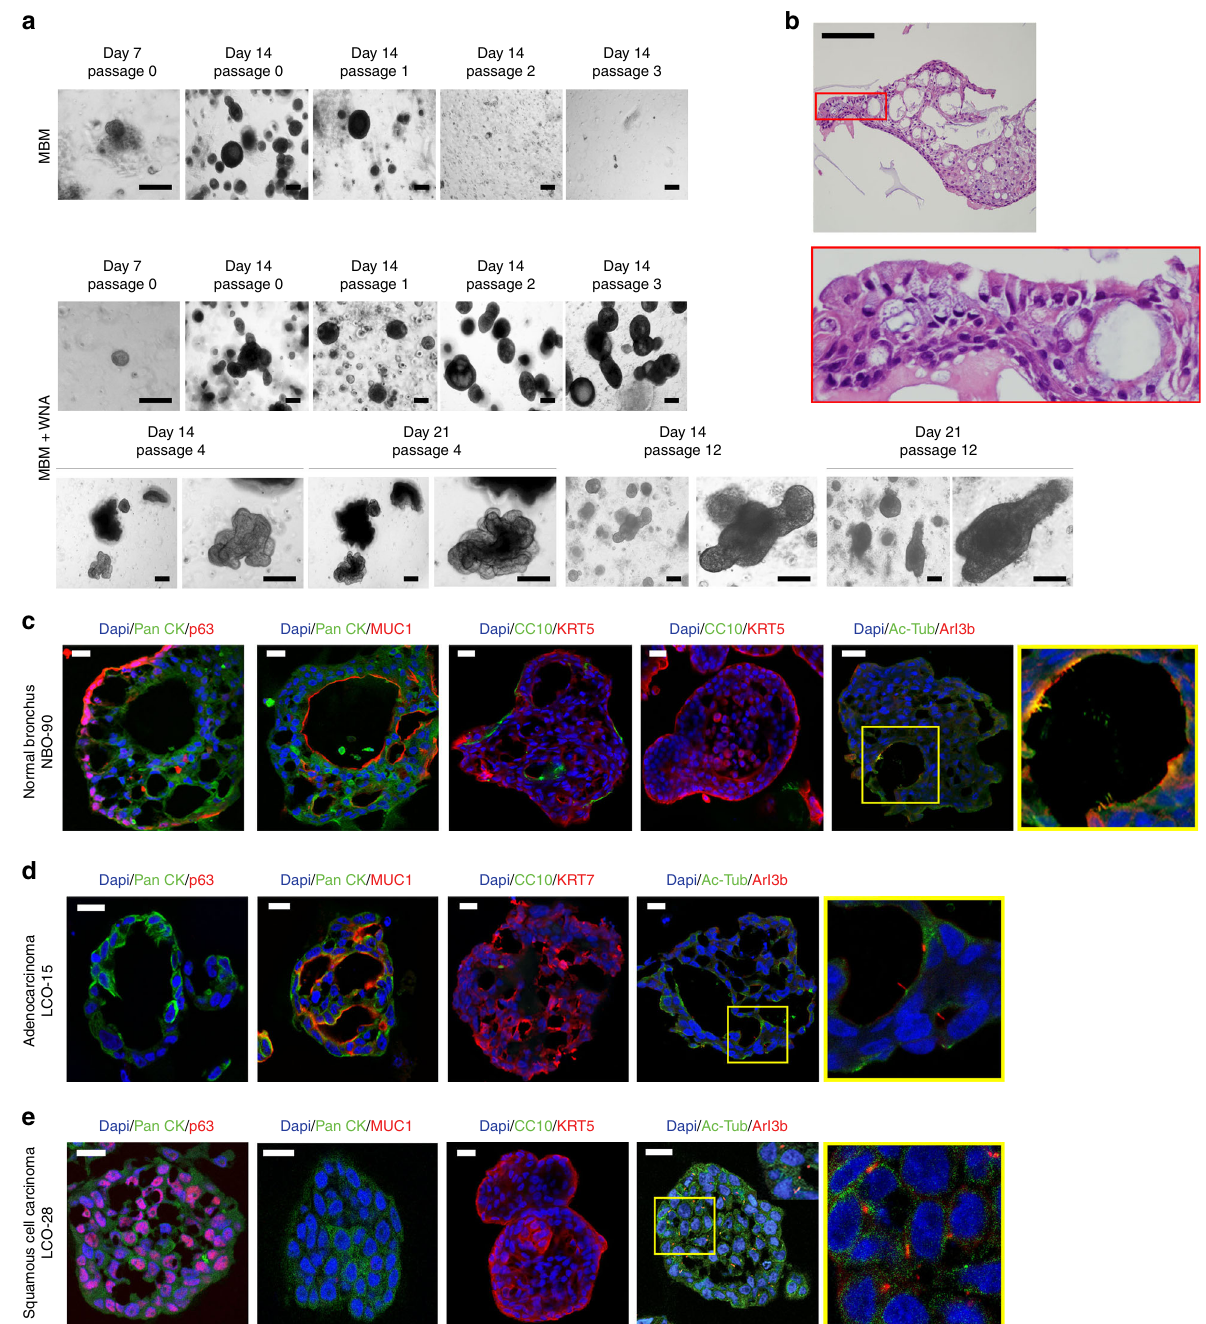
Fig. 4 Organ-like structures of the NBOs and LCOs. a Bright- fi eld microscopy images of a NBO, NBO-90. NBO-90 was cultured in MBM and MBM + WNA (W; Wnt3A, N; Noggin, A; A83-01). Scale bars, 200 μ m. b H&E staining image of NBO-90. Scale bar, 100 μ m. c – e Immuno fl uorescence images showing the expression of pancytokeratin, p63, MUC1, KRT5, KRT7, CC10, and cilia co-stained with acetylated α -tubulin (Ac-Tub) and Arl13b (The enlarged images in yellow boxes showed cilia co-stained with Ac-Tub and Arl13b). Nuclei (blue) were stained with DAPI. Scale bar, 20 μ